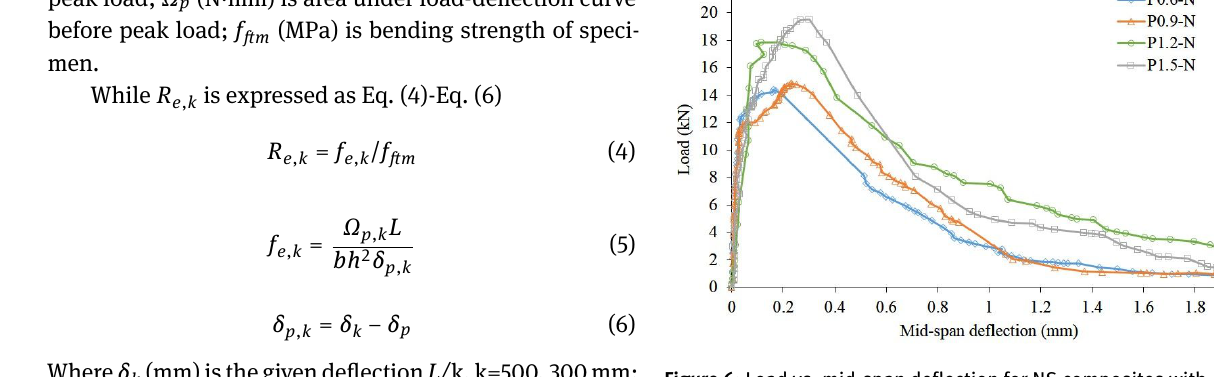
Figure 6: Load vs. mid-span deflection for NS composites with different PVA